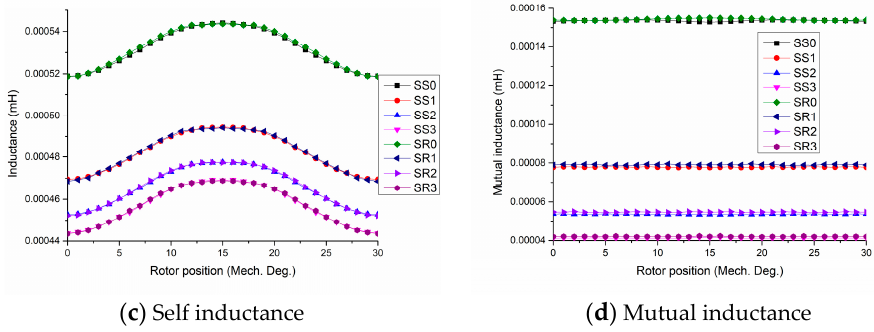
Figure 15. Overall performance comparison of CPM with different axial gap length, stator shifts (SS), and rotor shifts (RS).